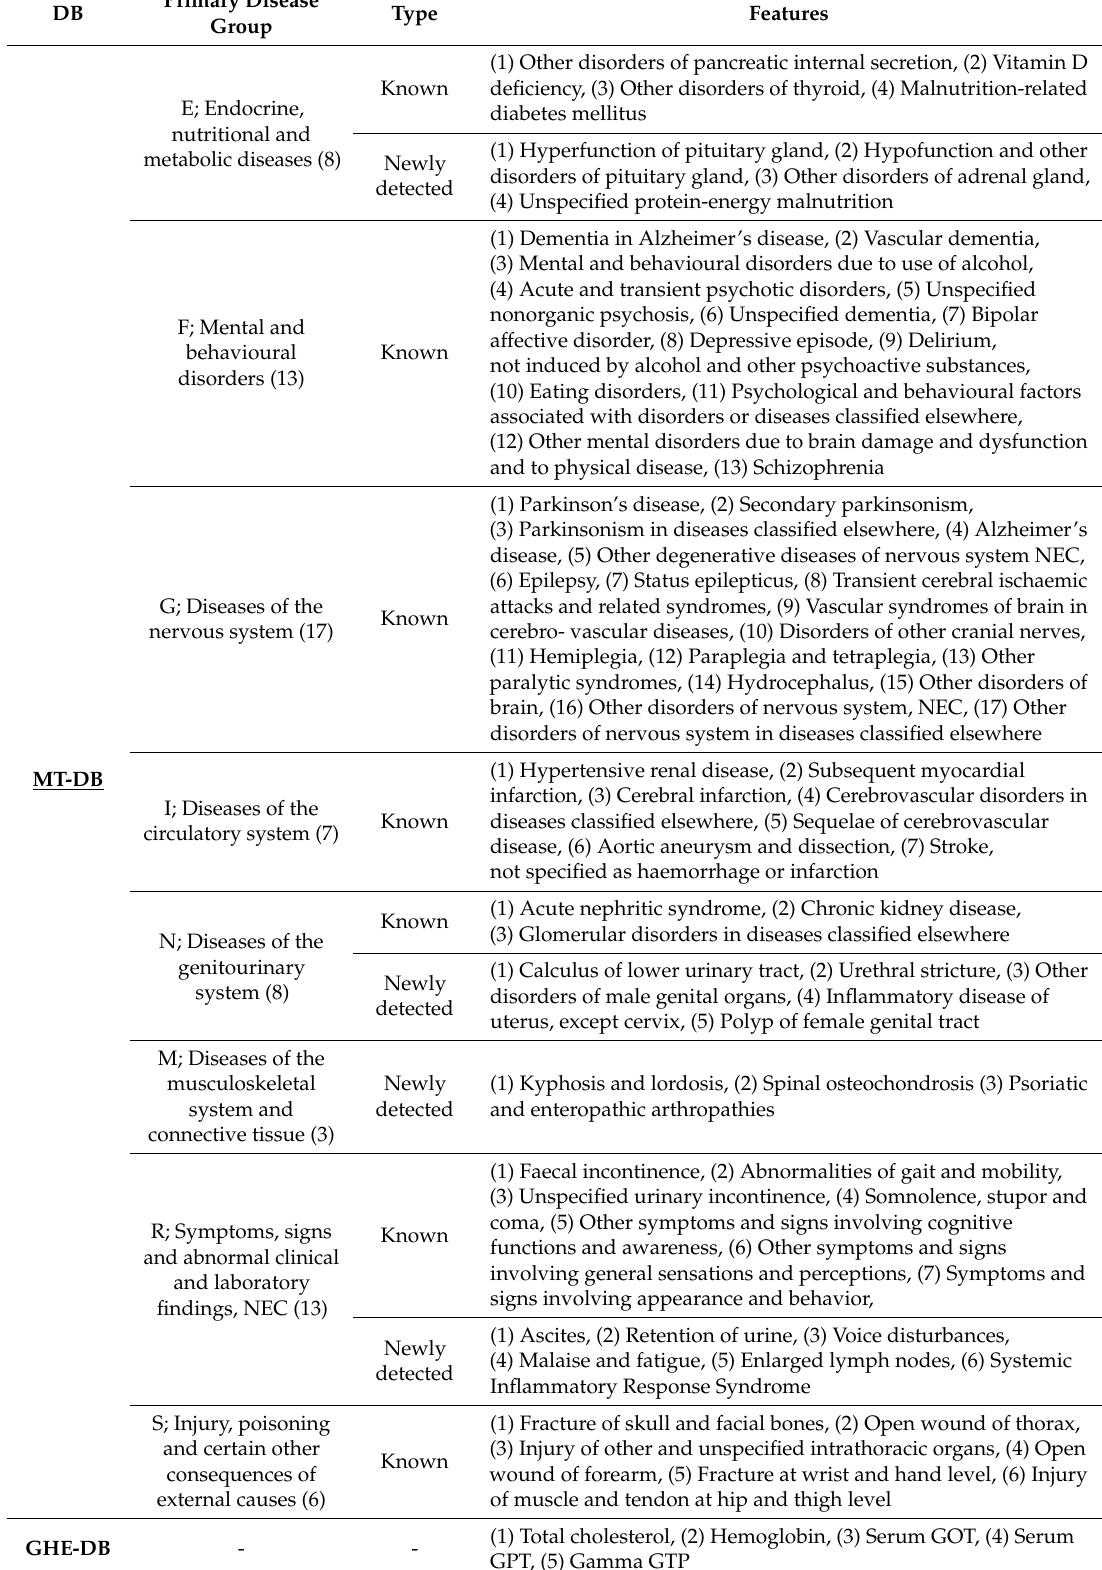
Table 10. Best feature